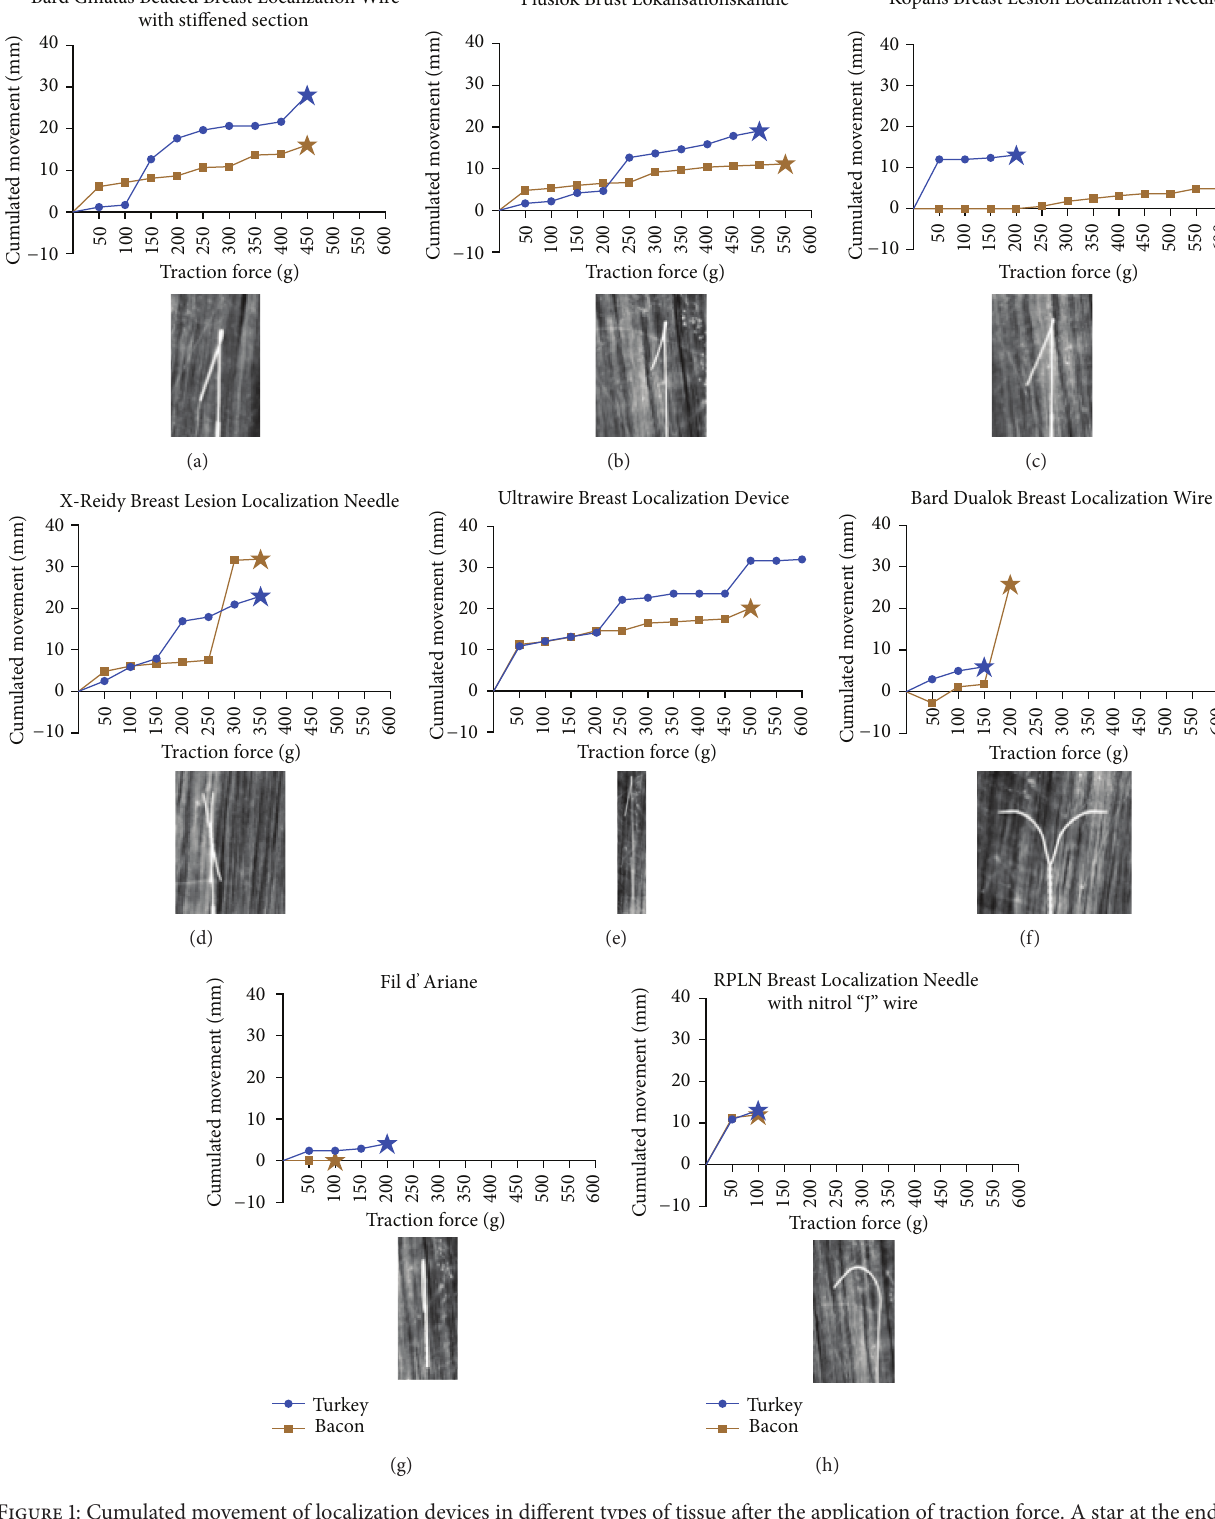
Figure 1: Cumulated movement of localization devices in different types of tissue after the application of traction force. A star at the end of a curve indicates the traction force with which the wire was completely removed from the